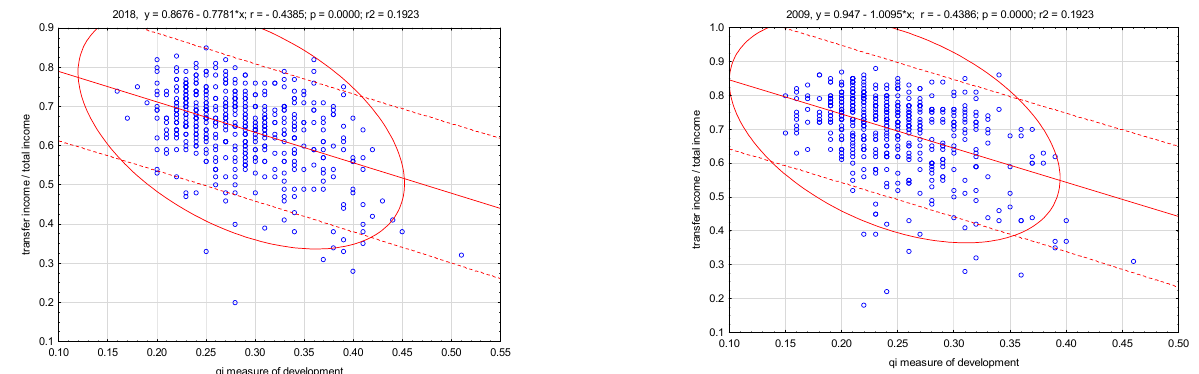
Figure 3. Dispersion of the synthetic measure of the financial situation of rural communes in eastern Poland in 2009 and 2018. Source: own research.